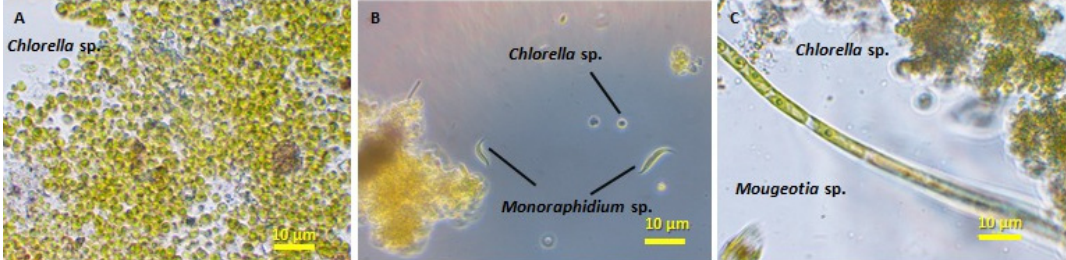
Figure 2. Microscope images of mixed liquor of the HRAP observed in bright light microscopy (×1000).